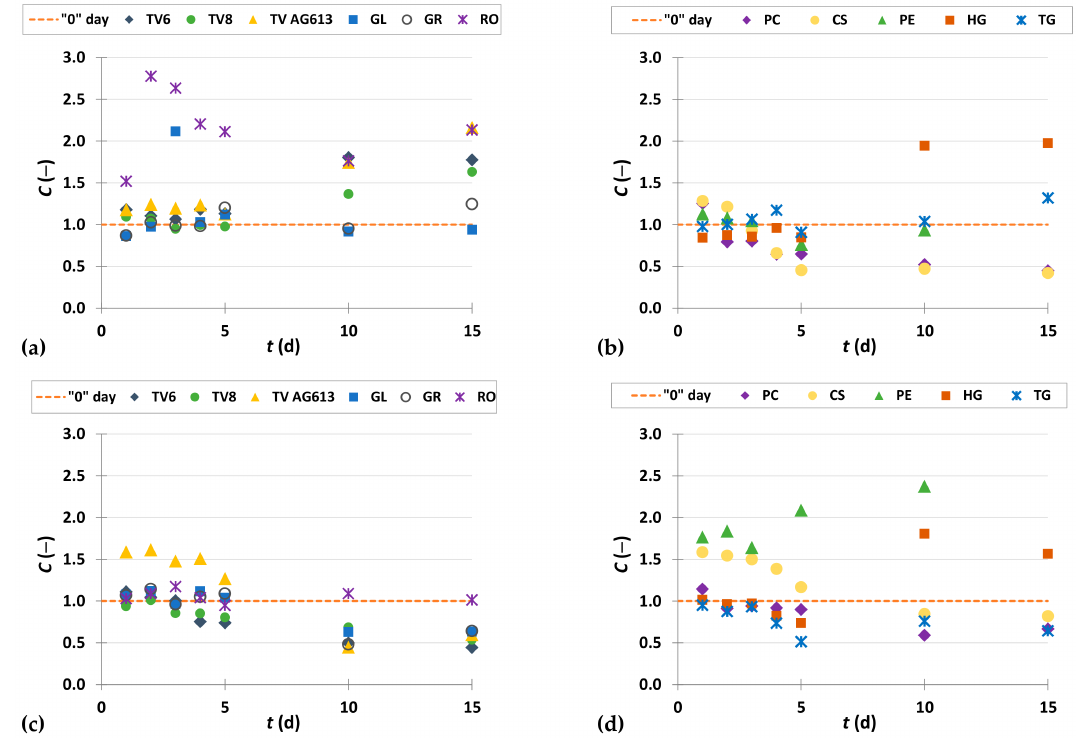
Figure 3. Dimensionless content ( C = C i / C o ) of p -hydroxybenzoic acid ( a , b ) and syringic acid ( c , d ) in GP extracts before biological treatment (‘0’ day) and after 1–15 days of biological treatment with TV6, TV8, TV AG613, GL, GR, RO ( a , c ), and PC, CS, PE, HG TG ( b , d